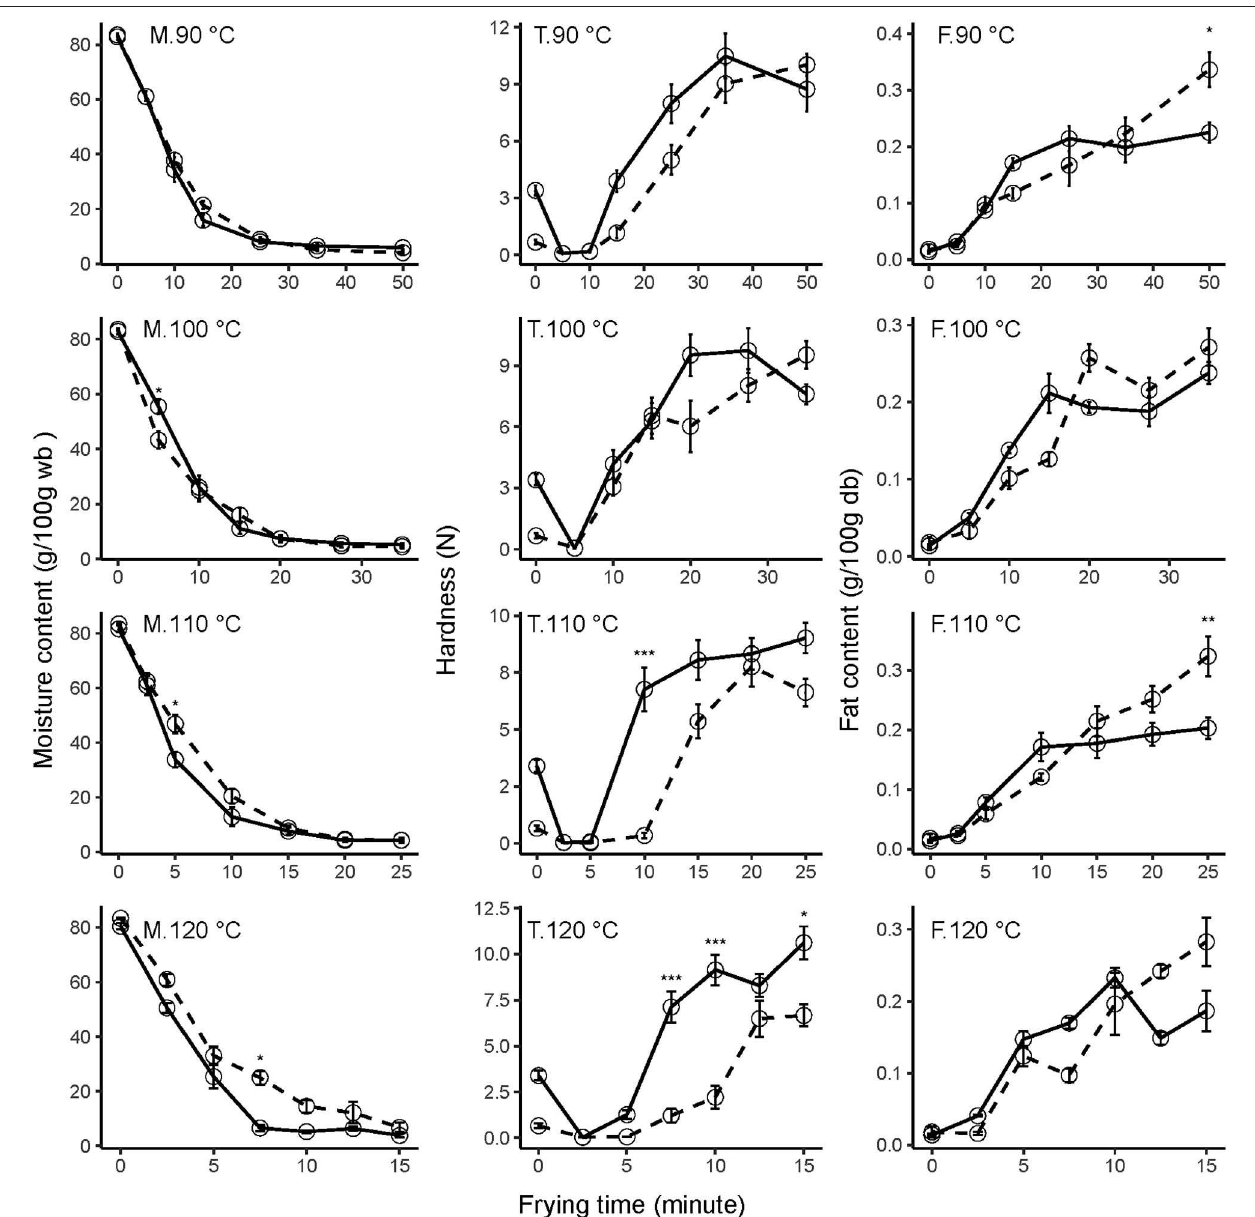
FIGURE 1 | Effect of frying temperatures, time, and ripening stage on moisture content (M), texture (T), and fat content (F) of mango chips during vacuum frying at 90, 100, 110, and 120 ◦ C. Solid lines are unripe mango, and dashed lines are ripe mango. Error bars are standard error. Asterisk shows significant difference between ripening stages (* p ≤ 0.05, ** p ≤ 0.01, ** p ≤ 0.001, *** p ≤ 0.0001). N = 6 (two frying experiments × 3 replications) for moisture content; 4 (two frying experiments × 2 replications) for fat content; 20 (two frying experiments × 10 replications) for